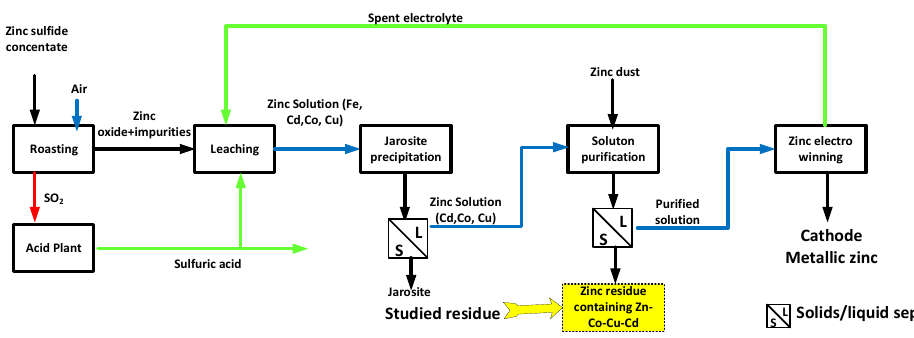
Figure 1. Simplified flowsheet of the zinc extraction process.